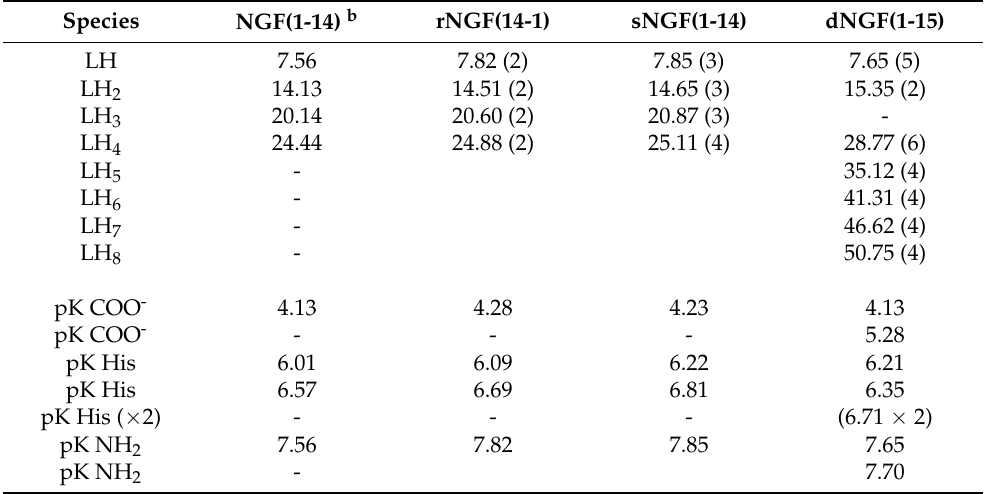
Table 1. Protonation constant (log β pqr) and pK values (T = 298 ◦ K and I = 0.1 M KNO 3 ) a